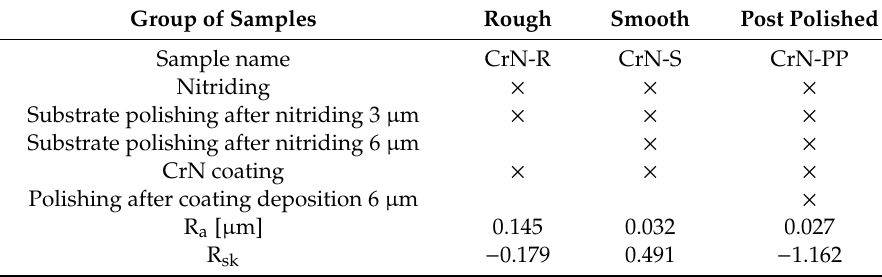
Table 1. Samples designations, production procedures and roughness parameters. Group of